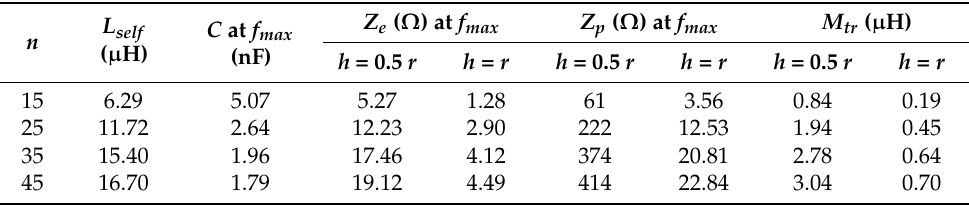
Table 4. Self and mutual inductances as well as compensating capacities and load impedance (at f max ) for circular coils and r = 10 mm.